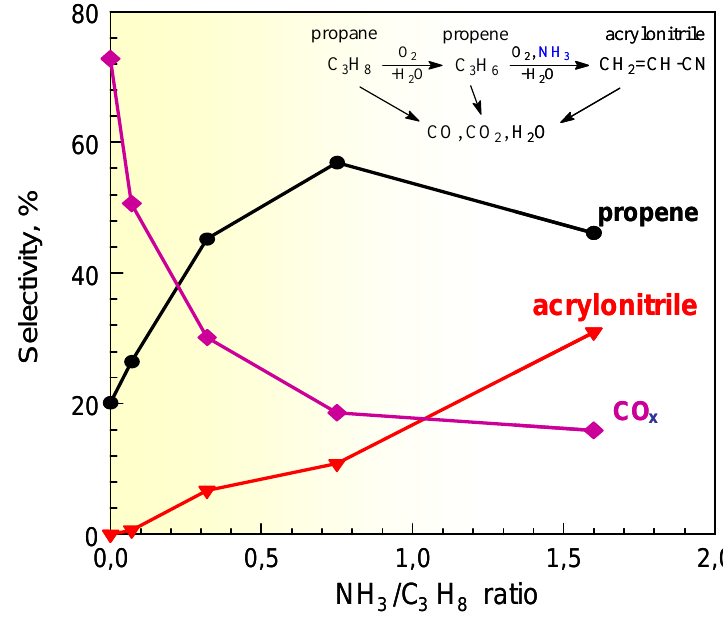
Figure 4. Selectivity to products in propane (amm)oxidation on VSbO the inlet ratio between ammonia and propane concentrations. Reaction temperatures: 480°C; 1% v/v propane, 15% O 2